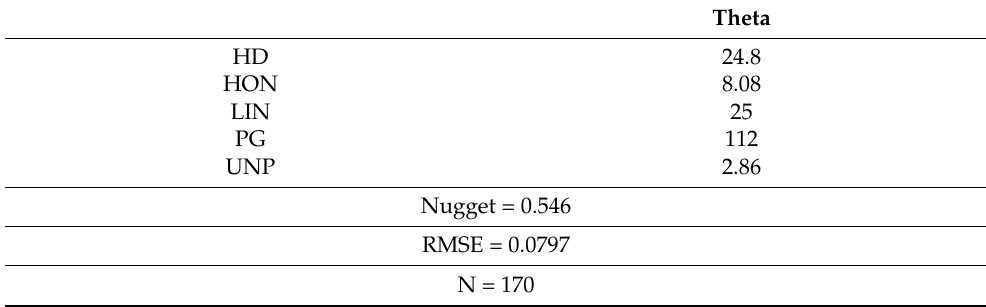
Table 5. Reduced